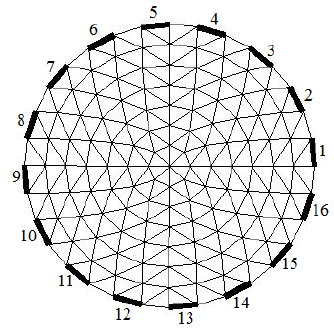
Figure 3: The uniform element model with 141 nodes, 248 elements and 16 electrodes